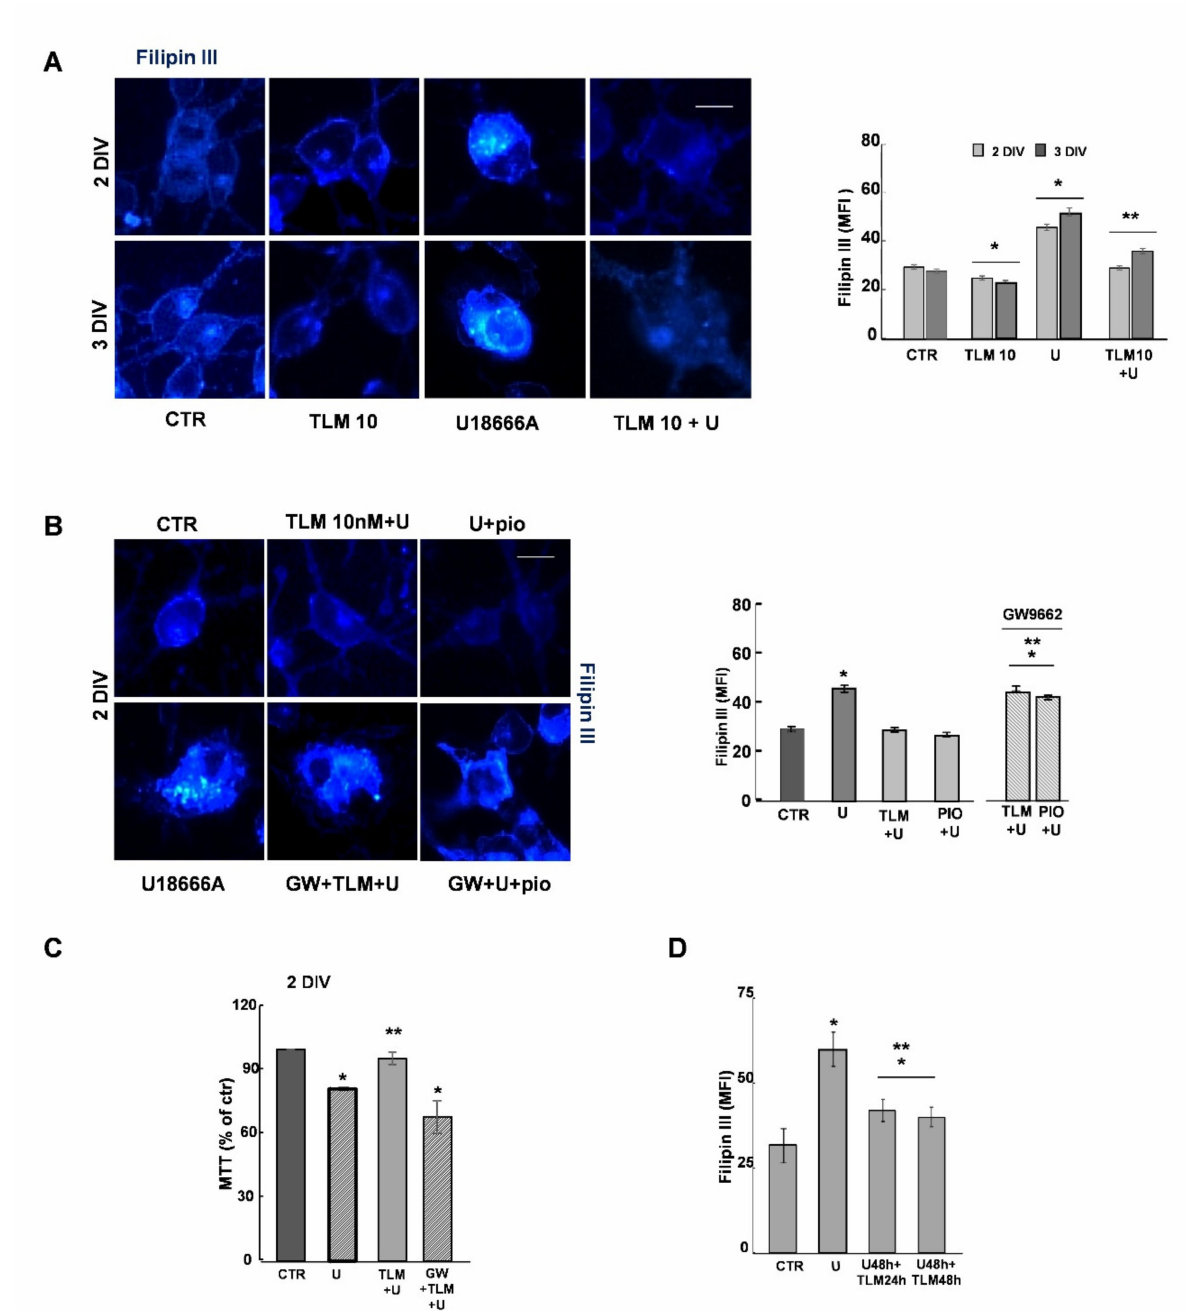
Figure 5. TLM redistributes the cholesterol in cultures treated with U18666A. ( A ) OPs were processed for Filipin III after a 24 h or 48 h treatment with 10 nM TLM and/or U18666A (U). Photomicrograph and the respective MFI values are shown. Data are expressed as Means ± SEM of 250–300 cells/condition ( n = 3; * p < 0.001 and ** p = 0.048 vs. U18666A (one-way ANOVA, unpaired two-tailed Student t -test). Scale Bar = 10 µ m. The OPs were treated with 1 µ M GW9662 (GW) in the presence of TLM, and U18666A (TLM+U) or pioglitazone and U18666A (PIO+U), and the cholesterol distribution was evaluated in ( B ). Means ± SEM of 4 independent experiments are shown (250–300 cells/condition; * p < 7 × 10 − 5 vs. CTR, ** p < 8 × 10 − 5 vs. TLM+U or PIO+U; one-way ANOVA, unpaired two-tailed Student t -test). Scale Bar = 10 µ m. The metabolic activity by the MTT test is shown in ( C ). Data are expressed as a percentage of control and represented the Means ± SEM of n = 5 * p = 0.001 and ** p = 0.039, one-way ANOVA, unpaired two-tailed Student t -test). The effect on cholesterol of TLM added in the last 24 h of U18666A is shown in ( D ). Data are Means of fluorescence intensity of Filipin III in each